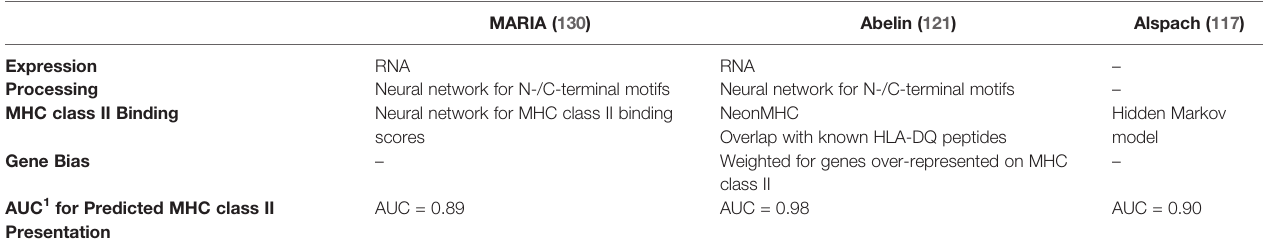
TABLE 6 | Summary of MHC class II-restricted neoantigen prioritization